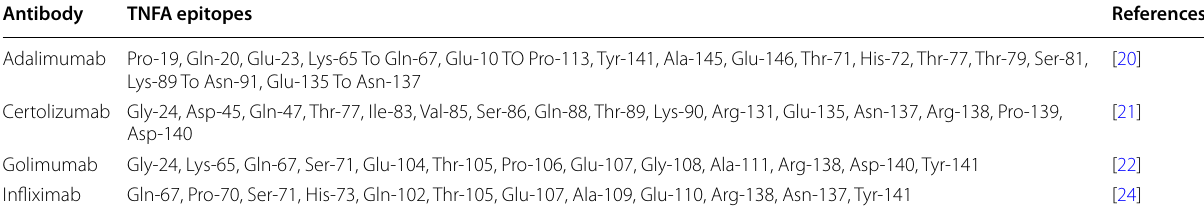
Table 1 Epitopes of TNFA for adalimumab, certolizumab pegol, golimumab and infliximab Antibody TNFA